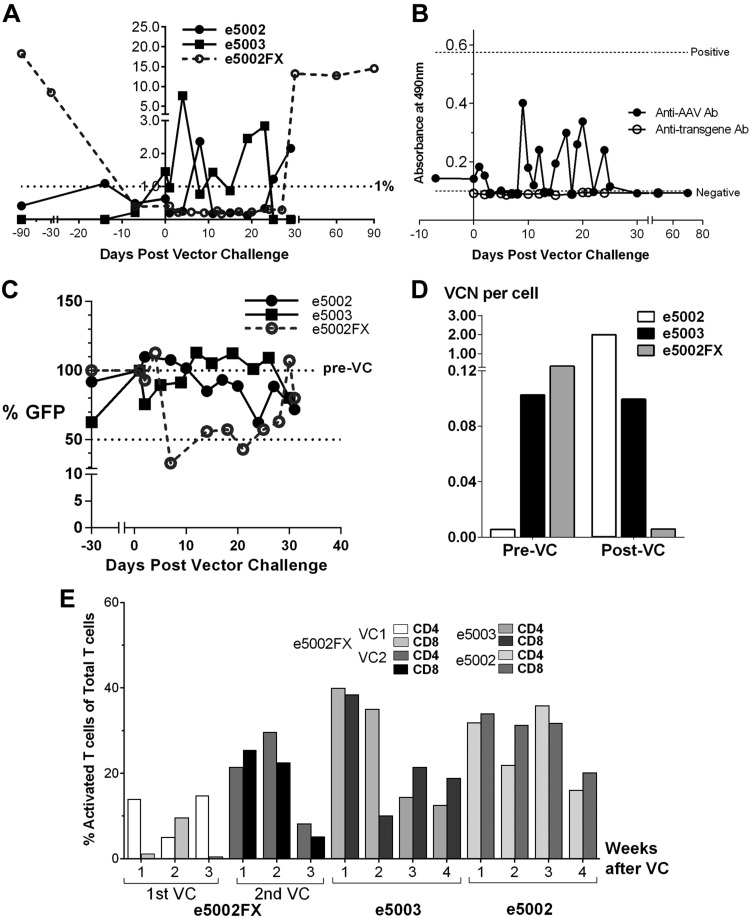
Postnatal VC and response. A) Three animals, e5002, e5003 (both AAV5-hFIX), and e5002FX (AAV5-hFX) received 2 × 1011 vg/kg AAV5. Transgene levels were <1% before VC (d 0). Brief improvements in expression were observed in e5003 after VC and were sustained over 23 d before being nullified. e5002 showed short spikes >1% at 8 and 24 d after VC, whereas e5002FX maintained <1% hFX until an increase was seen from d 27 after VC. B) Anti-AAV IgG antibodies increased mildly only in e5002 and e5003; no such reaction was observed in e5002FX, where anti-AAV5 IgG was undetectable. No IgG production against or was observed. C) The presence of NAbs was determined by loss of green fluorescent protein transduction to ≤50% of baseline transduction (normalized to 100%). e5002FX demonstrated NAbs from d 7 to 21 after VC before resolution. D) Pre- and postchallenge hepatic VCN showed various responses e5002 showed an increase from 0.01 to 2.00 copies/cell, whereas VCN in e5003 remained at 0.10 vector/cell. No further follow-up was possible, given that both recipients died at the postchallenge biopsy. A substantial decline from 0.35 to 0.01 copies/cell was observed in e5002FX. E) e5002FX showed an increase in activated CD4 and CD8 T cells producing TNF-α and IFN-γ from first to second postnatal VC, but this response quickly diminished by 3 wk after VC. Both e5002 and e5003 showed higher activated CD4 and CD8 T cells after VC, which similarly decreased over the following 4 wk.